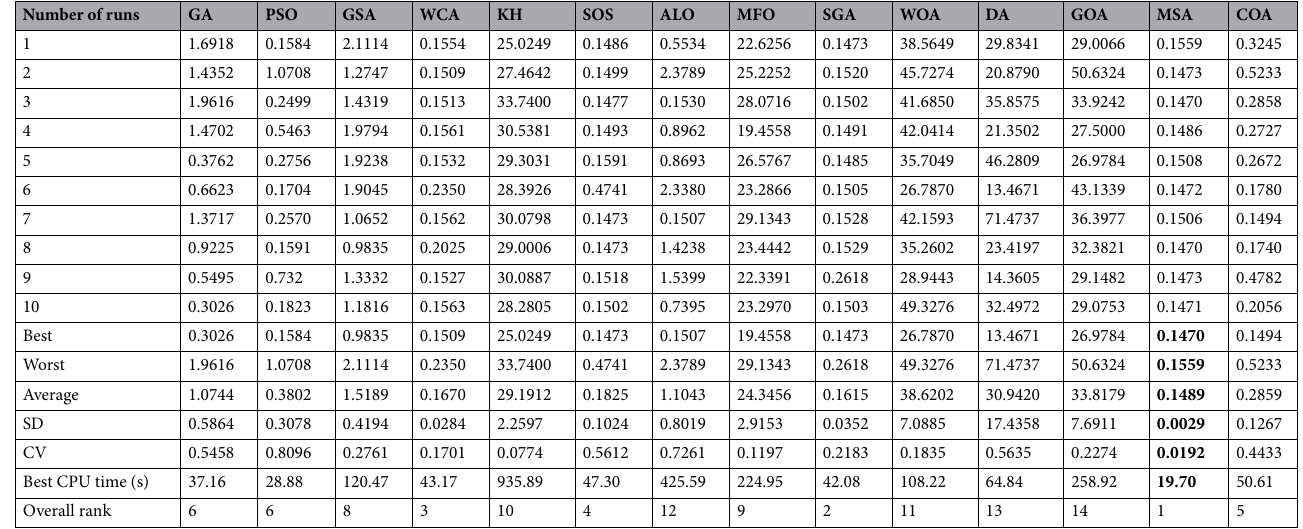
Table 4. The values of objective function for 10 runs of utilized algorithms. Significant values are in